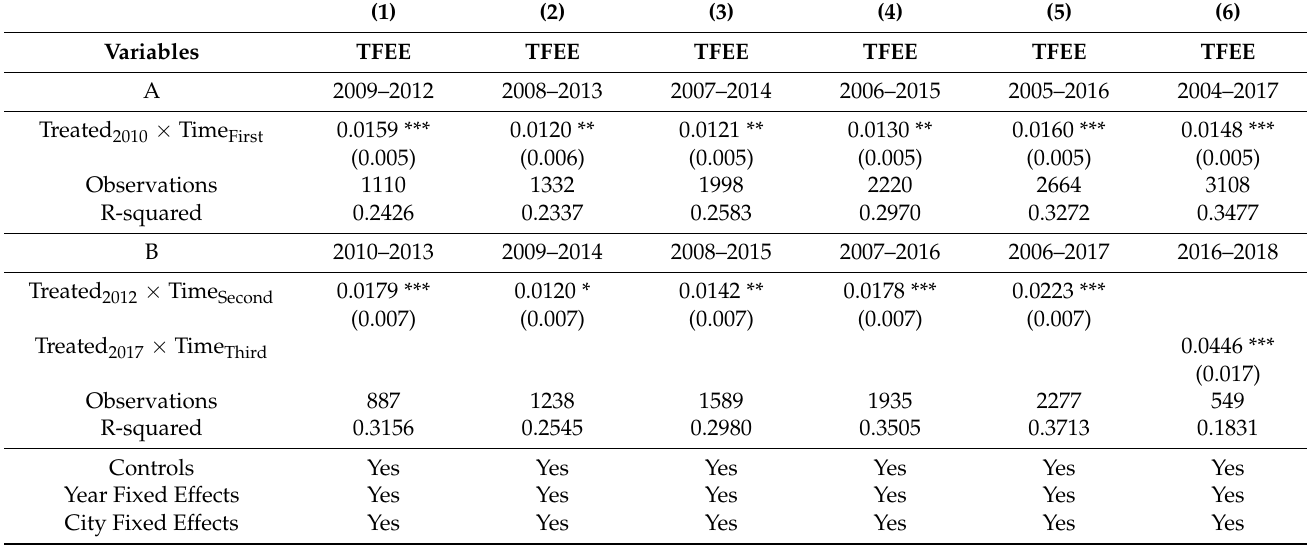
Table 5. Robustness test: dynamic